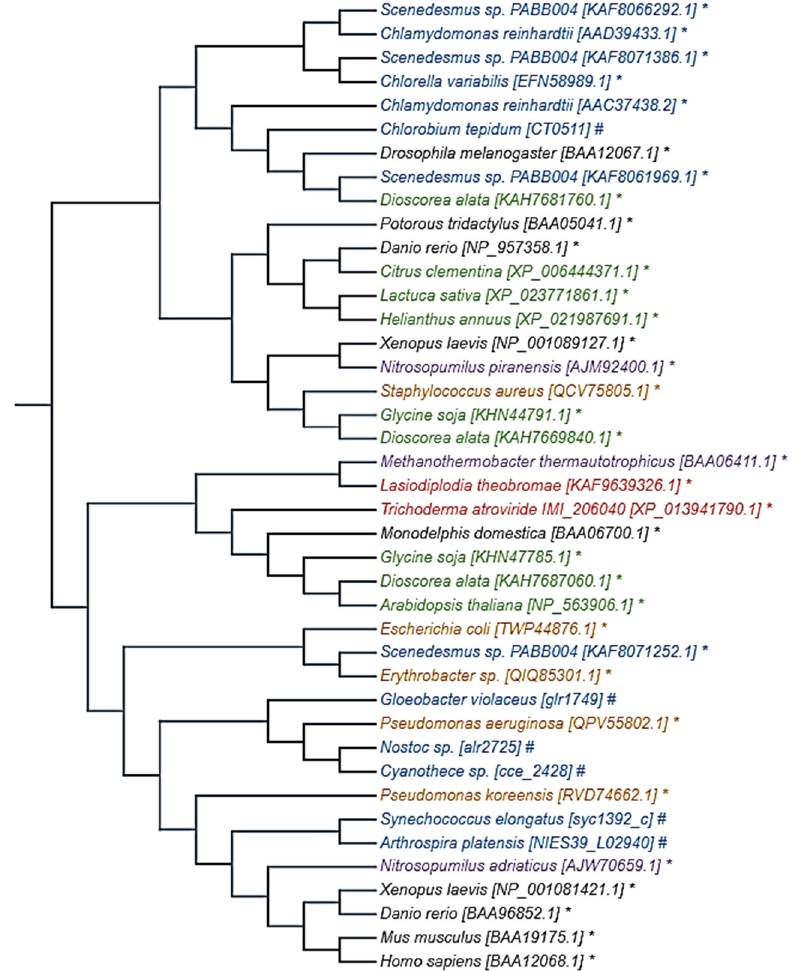
Figure 2. Phylogenetic tree of photolyase. An evolutionary relationship among several members of the photolyase family is shown. This relationship was inferred using the neighbor-joining method [17] with the Poisson correction method [18] in MEGA11 [19]. Amino acid sequences from different species were obtained from the NCBI protein database (*) and CyanoBase database (#), and ID number is between square brackets. Colors are used as group identifiers: black for animals, green for plants, blue for microalgae (eukaryotic and cyanobacteria), red for fungi, orange for bacteria (except for cyanobacteria), and purple for arquea.